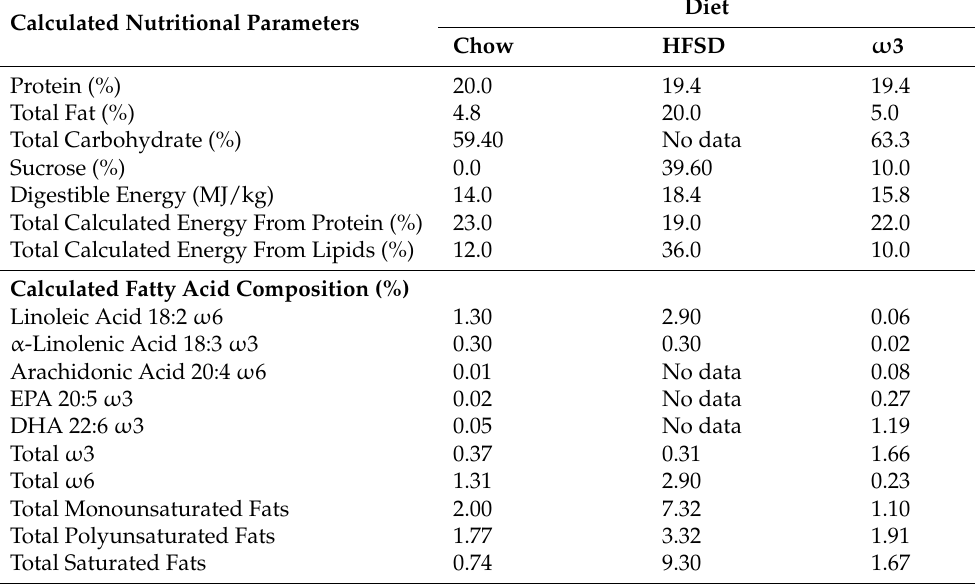
Table 1. Nutritional parameters and fatty acids composition of chow, HFSD and ω 3